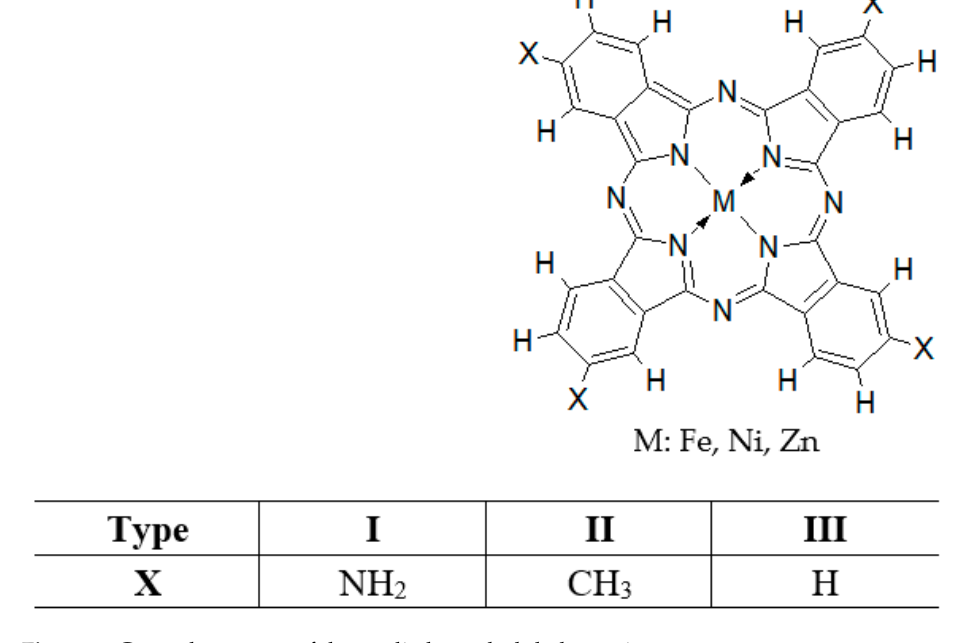
Figure 1. General structure of the studied metal-phthalocyanines.